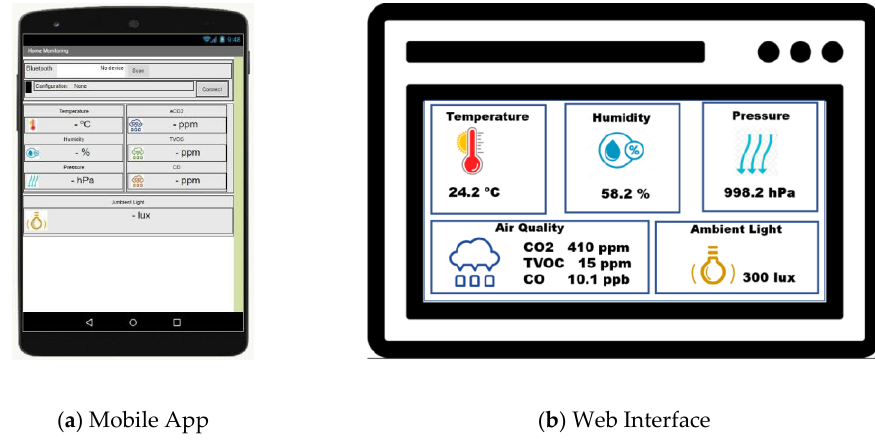
Figure 11. Mobile App and Web Interface developed for the experimental framework.